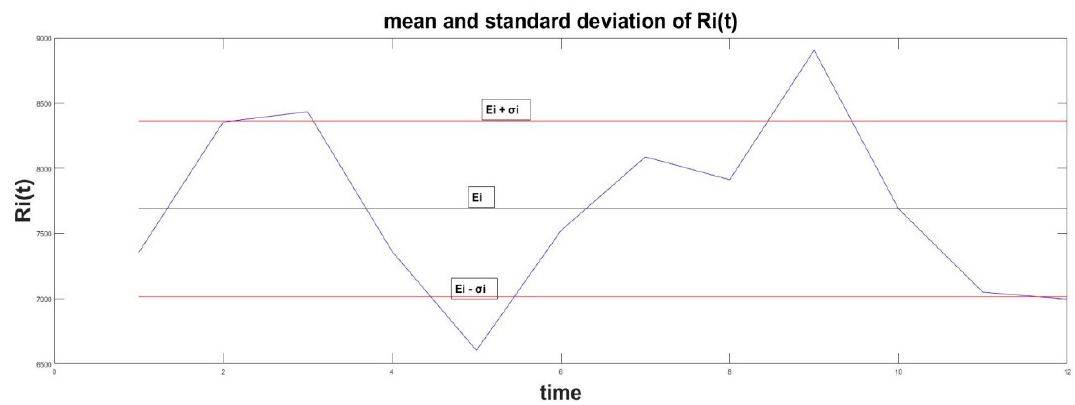
Figure 1. Illustration between the mean E i , standard deviation σ i , and stochastic value R i ( t ). Hence, if the standard deviation σ i has a small value, then the real value of the return R i ( t ) will be close to the mean estimation E i and the decision maker can use this value E i as a forecast for the future level of asset return. These asset parameters are used for the evaluation of the portfolio return and risk.